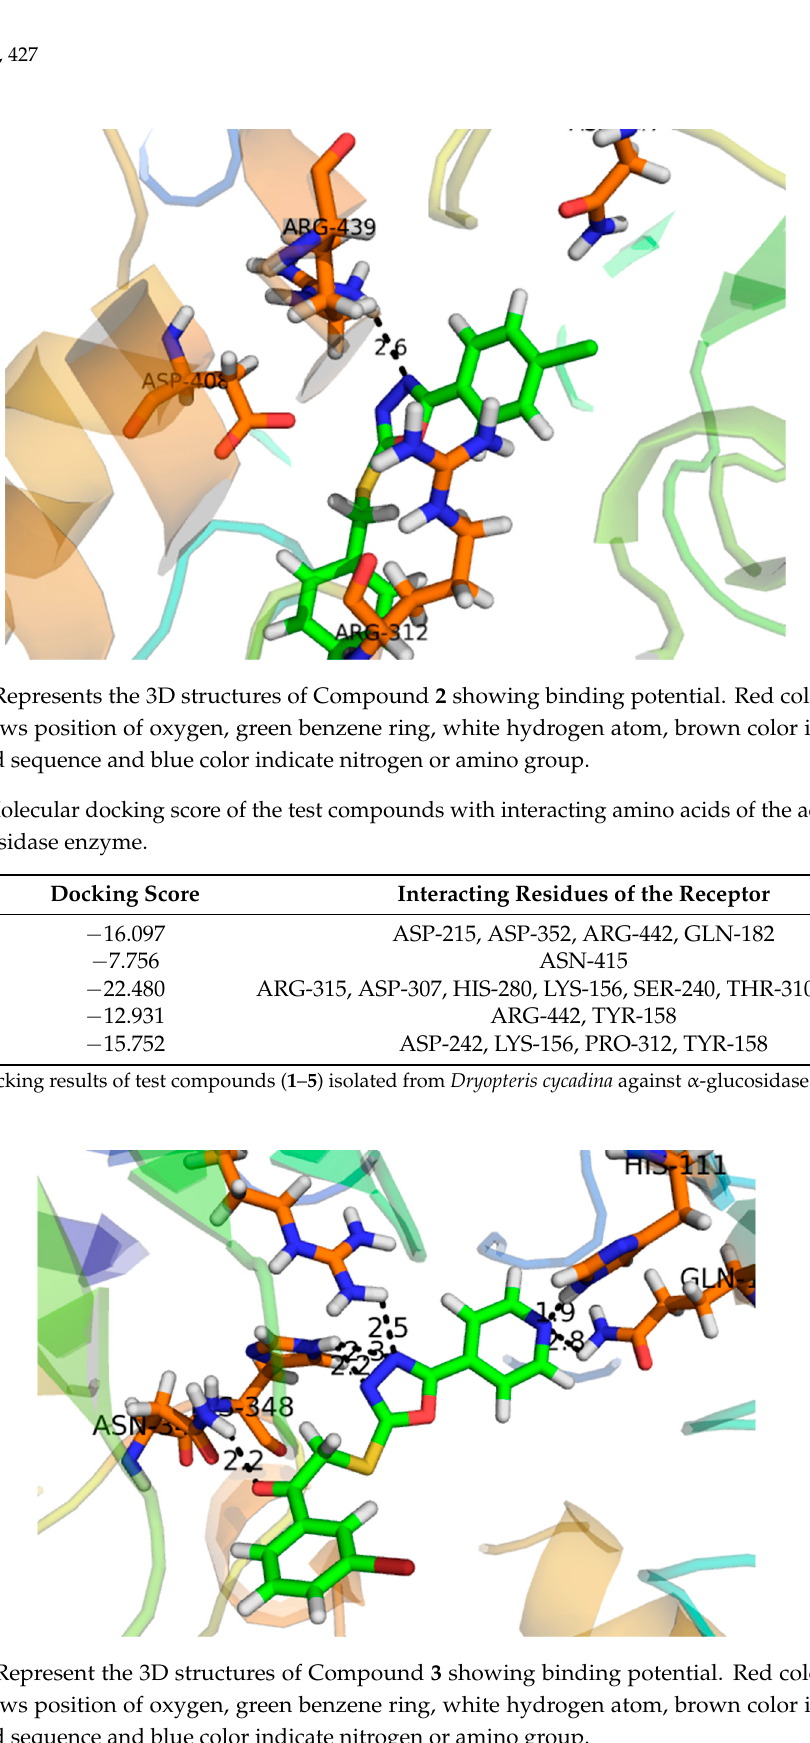
Figure 6. Represents the 3D structures of Compound 4 showing binding potential. Red color in the image shows position of oxygen, green benzene ring, white hydrogen atom, brown color indicates amino acid sequence and blue color indicate nitrogen or amino group.